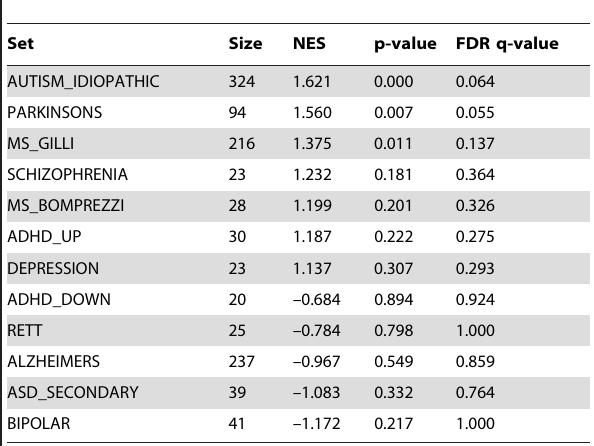
Table 4. Sets associated with human neurological disorders.